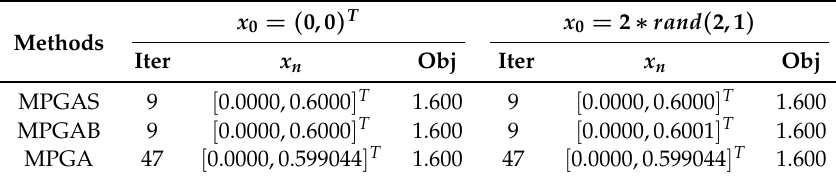
Table 1. Results for Example